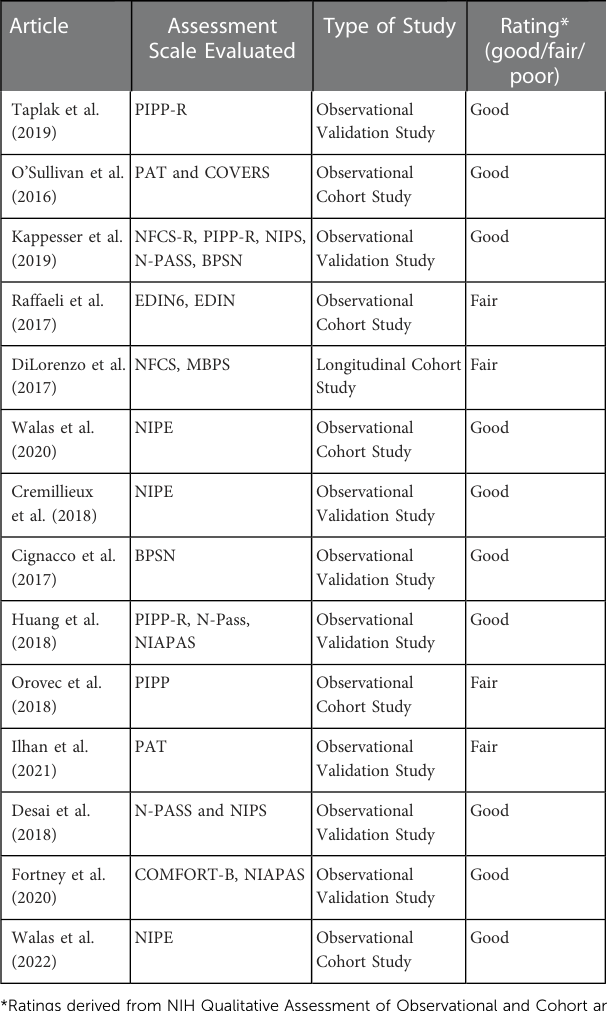
TABLE 1 Qualitative assessment of observation and cohort and cross- sectional studies involving neonatal pain assessment